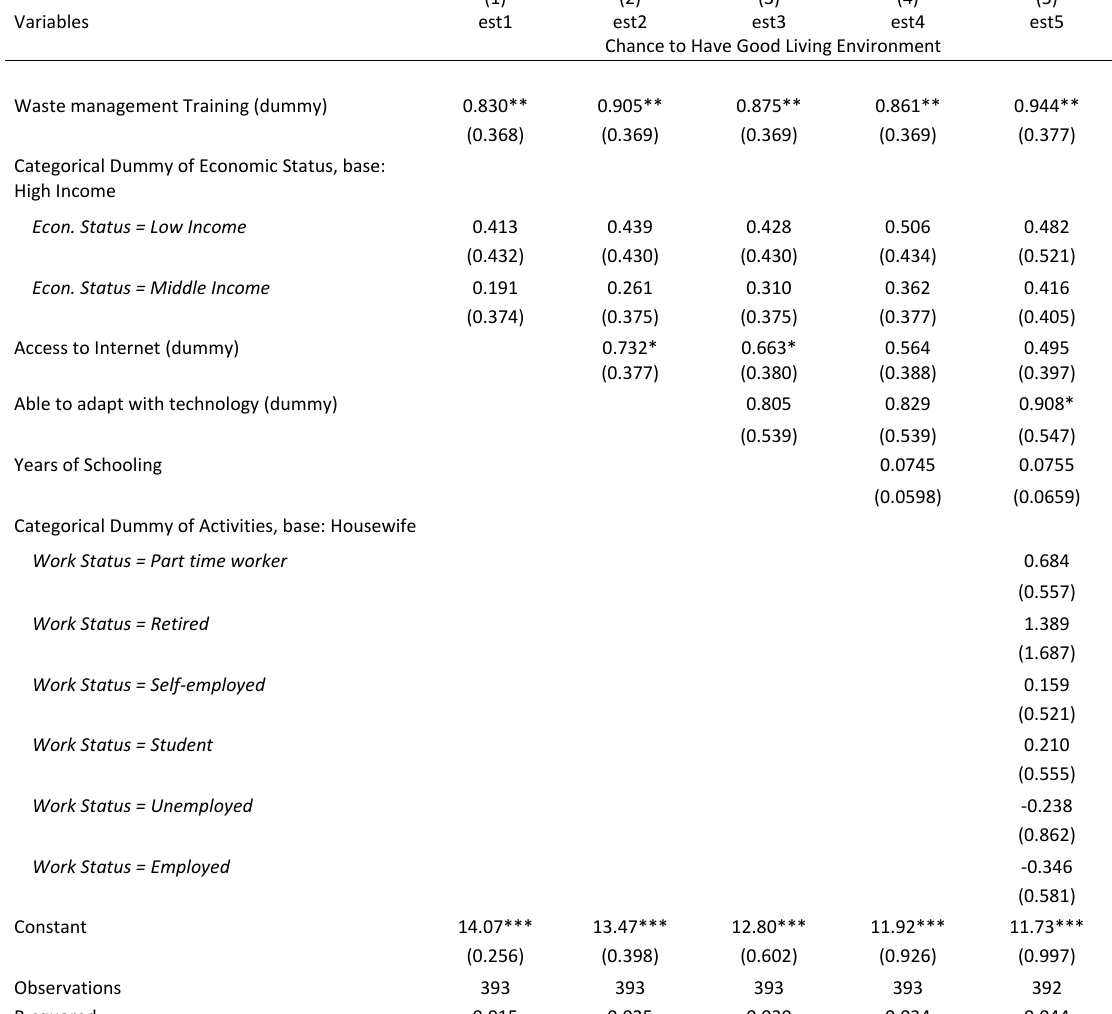
Table 1: Significant test results from regression analysis